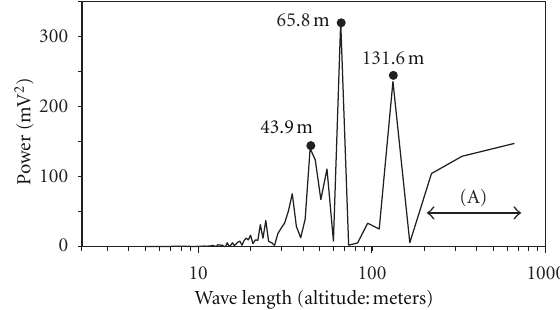
Figure 4: Power spectrum of spatial SP distribution against alti- tude. Three peaks are obvious. Spectrums with longer wavelength are denoted as